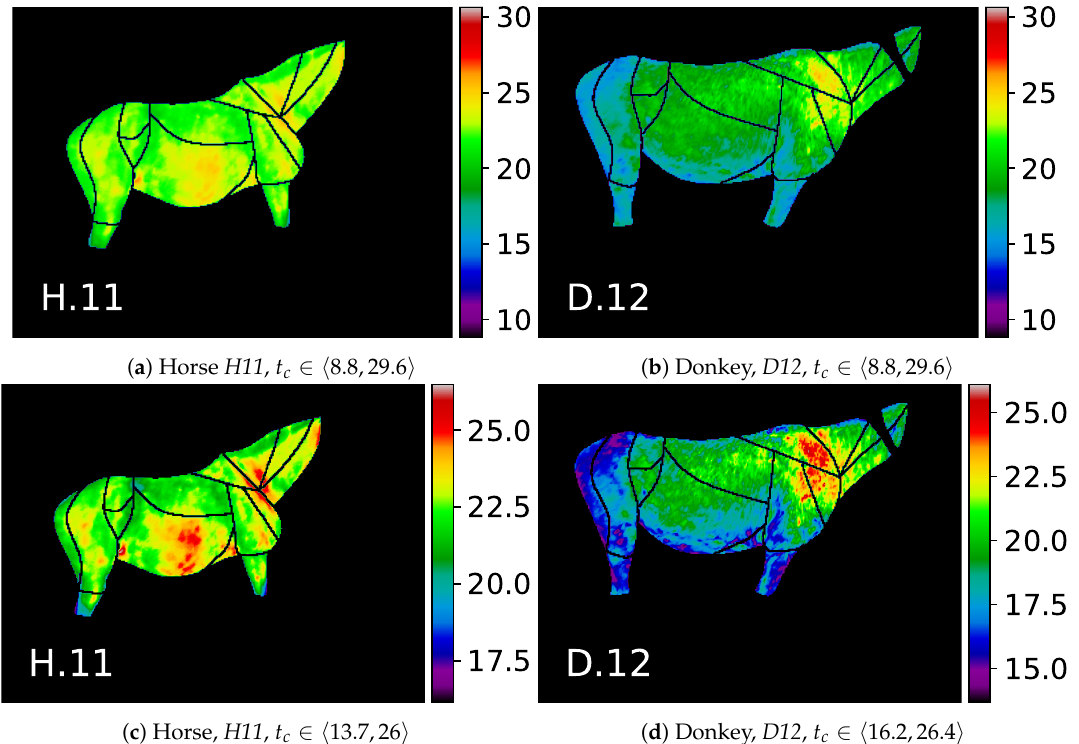
Figure 10. Selected examples of two animals from the dataset. The color map values t c for images in the upper row are scaled to the common range, which makes them easy to compare: ( a ) horses; ( b ) donkeys. Images in the bottom row are scaled to the minimal and maximal temperatures in the annotated ROIs of each animal, which highlights individual thermal patterns: ( c ) horses; ( d ) donkeys; e.g., warm horse’s GORs Abdomen and Neck , cool donkey’s GOR Rump , and warm donkey’s GOR Front quarter